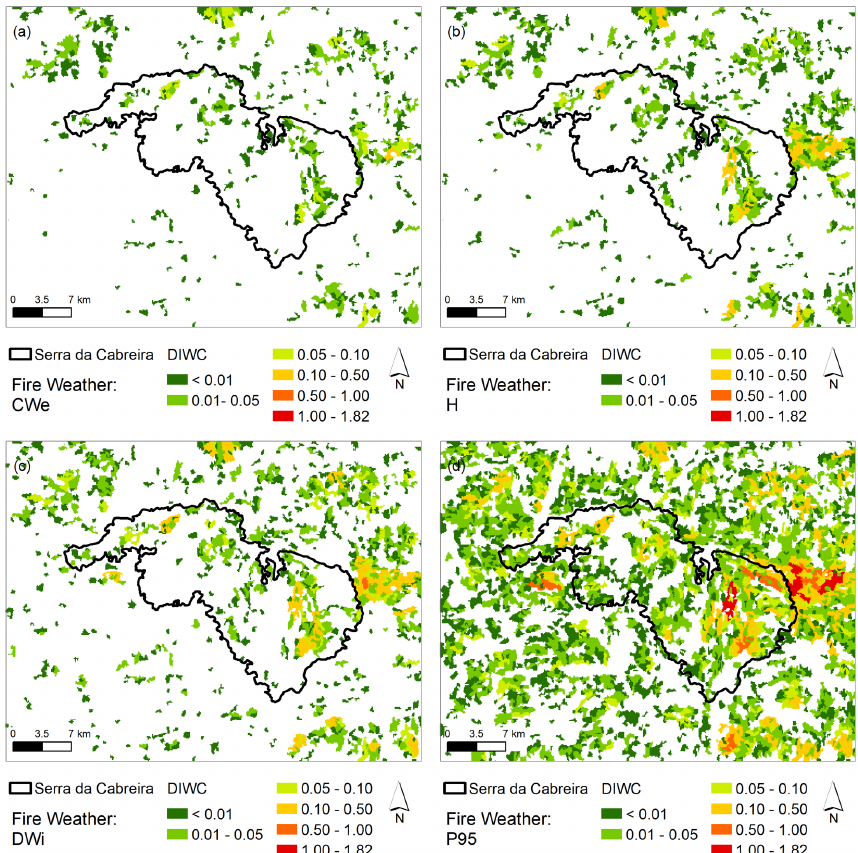
Figure 9. Normalized wildfire connectivity (DIWC) calculated for the historical – (a) CWe, (b) H and (c) DWi – and (d) extreme fire weather conditions. Only fuel patches with estimated FLI > 4000kWm − 1 (high-FLI